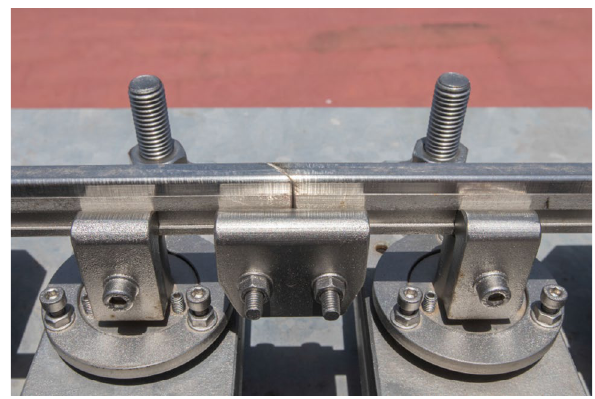
Figure 11. Rail to rail clamp. Photographer: Ludivine Mimar.